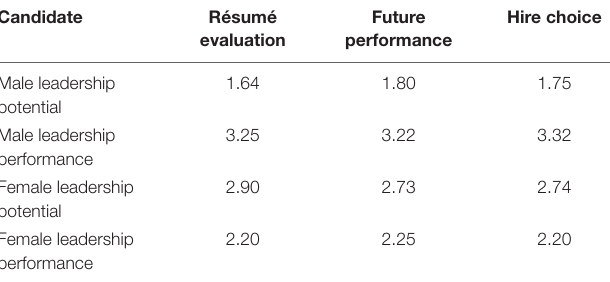
TABLE 5 | Mean rank for each candidate for résumé evaluation, future performance, and hire choice (Experiment